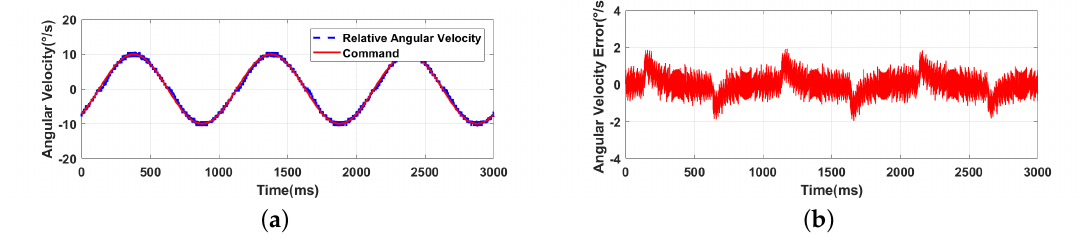
Figure 9. Group A: PI controller u c with a heavy base support. ( a ) Sine command and relative angular velocity; ( b ) Relative angular velocity error.